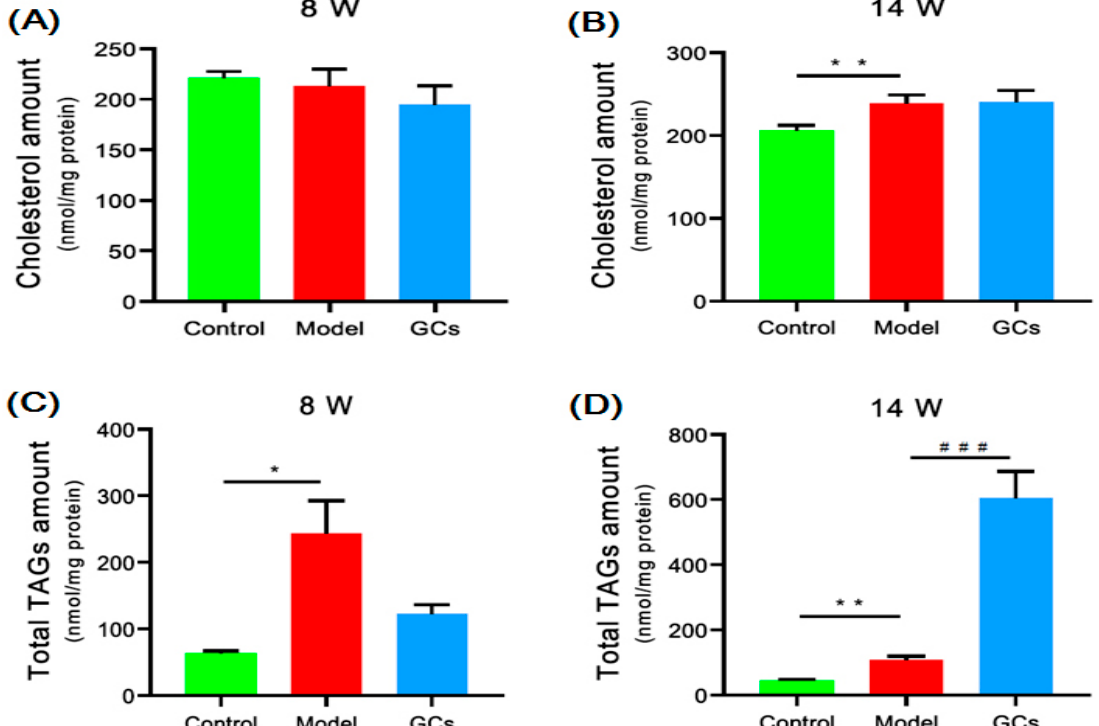
Figure 3. Comparison of the total mass levels of cholesterol and triacylglycerol (TAG) species deposited in renal tissues from MRL/lpr mice at different states of lupus nephritis (LN). The kidney samples of the control ( n = 4, green), model ( n = 4, red), and GCs ( n = 4, blue) groups were collected at 8- (pre-LN state) and 14-weeks of age (LN state), respectively. Lipidomics analysis of cholesterol (Panels A and B ) and TAGs (Panels C and D ) present in lipid extracts of kidneys was conducted by using multidimensional mass-spectrometry-based shotgun lipidomics. The data present means ± SEM from different groups. * p < 0.05 and ** p < 0.01 compared with those in the control group. ### p < 0.001 compared with those in the model group. TAG denotes triacylglycerol.